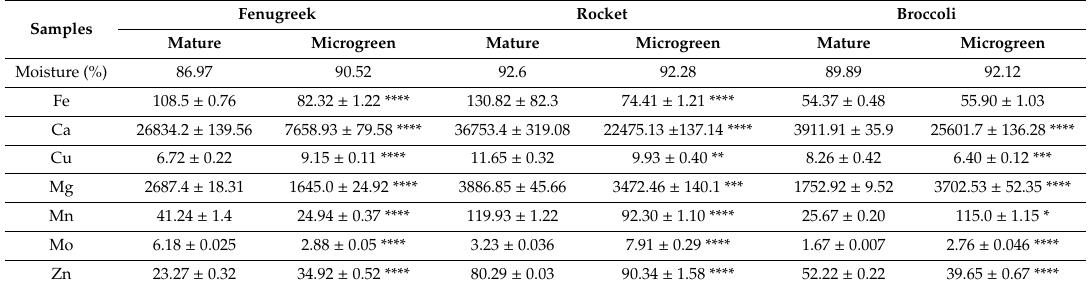
Table 1. Moisture and mineral content in the dried vegetable samples ( µ g / g).